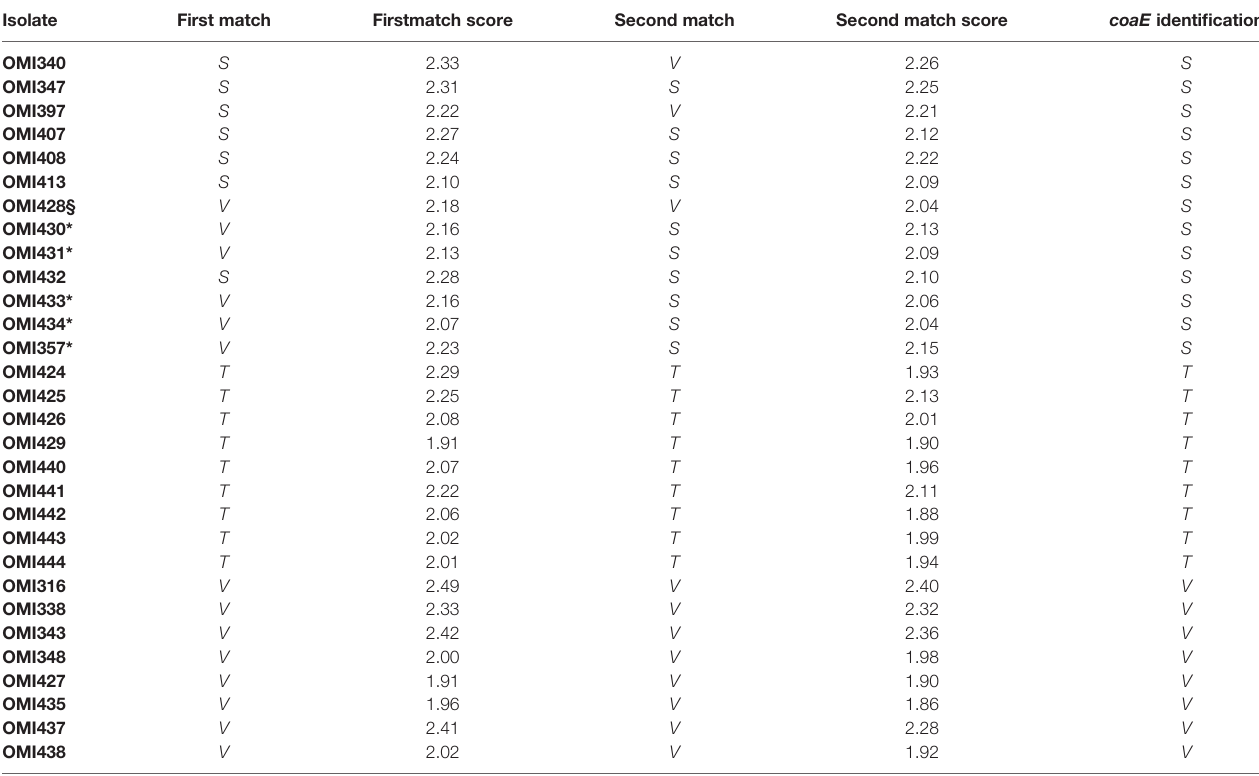
TABLE 1 | Comparison between MALDI-TOF MS and coaE typing results of the 30 salivarius group streptococcal (OMI) isolates included in this study. Isolate First